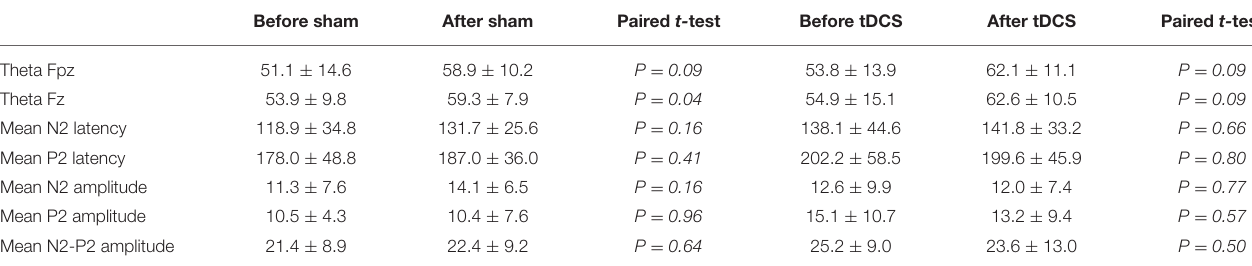
TABLE 5 | Neurophysiological (EEG and PREPS) results (Mean ± SD) before and after sham and active tDCS. Before sham After sham Paired t- test Before tDCS After tDCS Paired t-